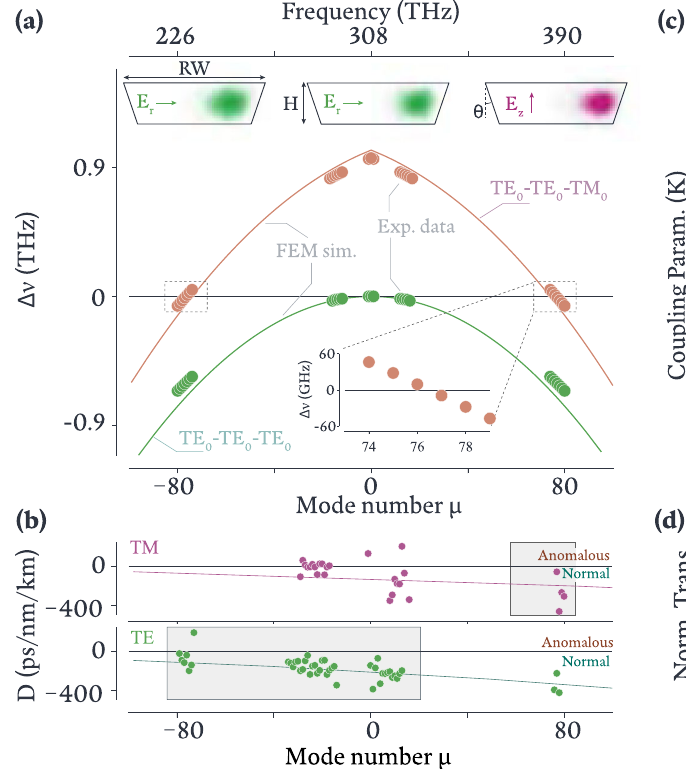
solid points and fi ts shown as solid curves. The gray boxes highlight the relevant spectral bands (signal for TM 0 and idler and pump for TE 0 ). D <0 for the relevant mode family for each of the idler, pump, and signal bands. c Coupling parameter ( K ), de fi ned as the ratio of the resonator-waveguide coupling rate ( κ ext ) to the resonator intrinsic loss rate ( κ int ), for the idler, pump, and signal modes (blue, green, and orange) as a function of resonator-waveguide gap. The top inset shows an optical micrograph of one device, where the scale bar is 5 μ m, along with the refractive index (thin black) pro fi le along a cross-section through the ring and waveguide (wg), and the radial component of the evanescent tail of the idler and pumpmodes(blackandgreencurves). d Transmissionspectrafortheidler,pump, and signalmodes ata gapof 300nm, along with fi tting results for theintrinsicand coupling quality